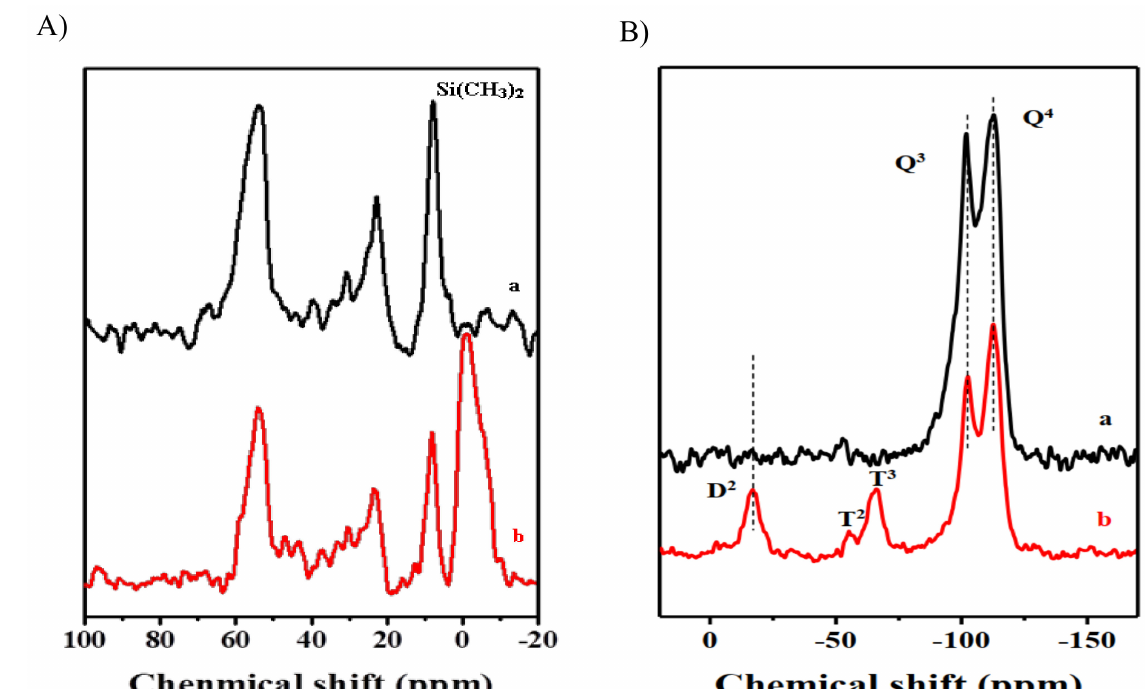
Figure 10. ( A ) 13 C MAS NMR spectra and ( B ) 29 Si MAS NMR spectra of ( a ) COK-5 and ( b ) IEZ-COK-5. Reprinted with permission from ref. [40]. Copyright 2015,